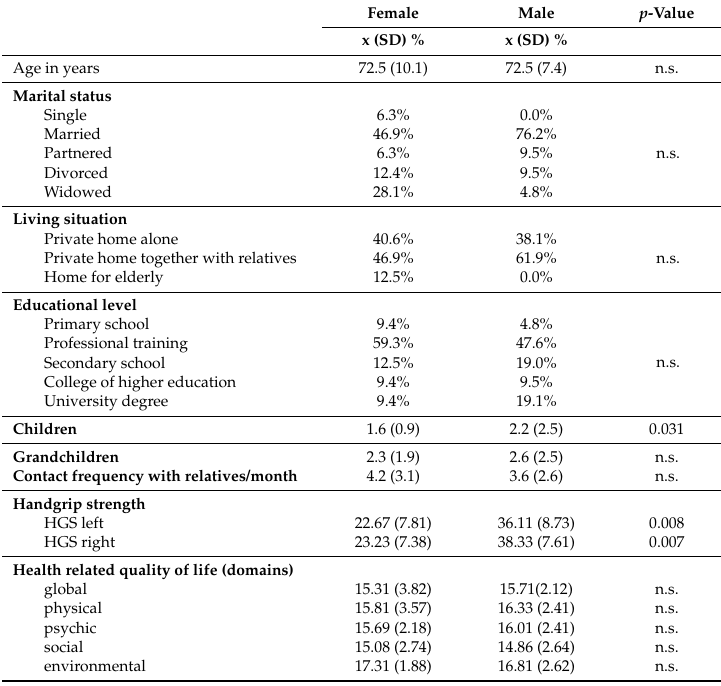
Table 1. Sample description according to sex ( χ 2 )/u-test.